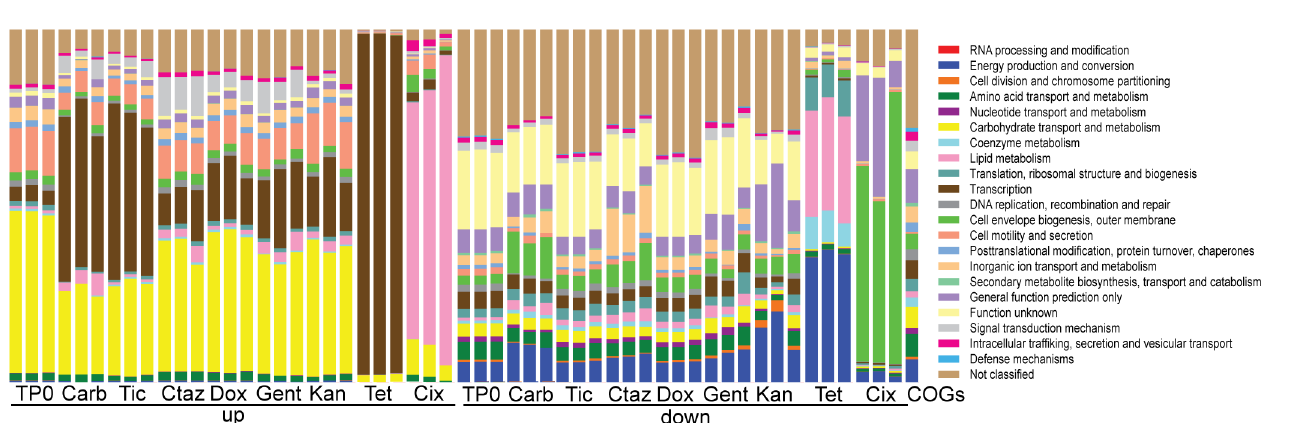
Fig 3. Clusters of Orthologous Groups (COGs) relative abundance of selected populations. Label format is Antibiotic_replicate_up/down, e.g., CarbOD_1_up means COG counts for carbenicillin, replicate 1 of 3, and TRMR “ up ” alleles. Antibiotic abbreviations: Carbenicillin (Carb), Ticarcillin (Tic), Ceftazidime (Ctaz), Cefixime (Cix), Gentamicin (Gent), Kanamycin (Kan), Doxycycline (Dox), and Tetracycline (Tet). Far right bar: COG distribution as represented in the wild-type E . coli genome.